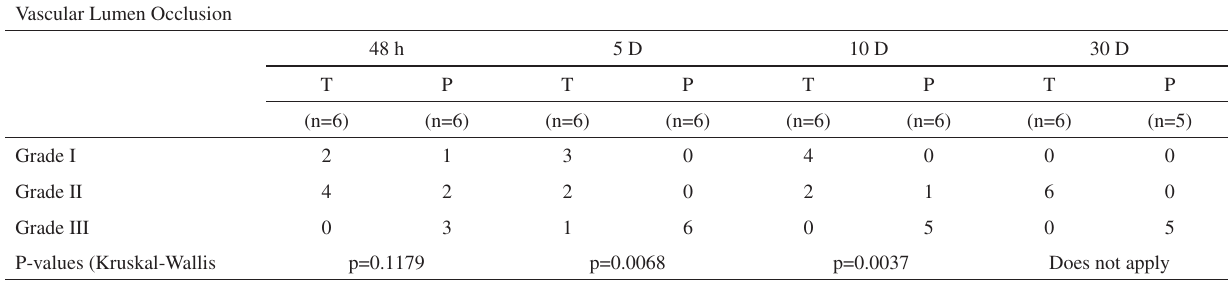
Table 1 - Vascular lumen occlusion related to the time after embolization with either trisacryl (T) or PVAc (P) Vascular Lumen Occlusion 48 h 5 D 10